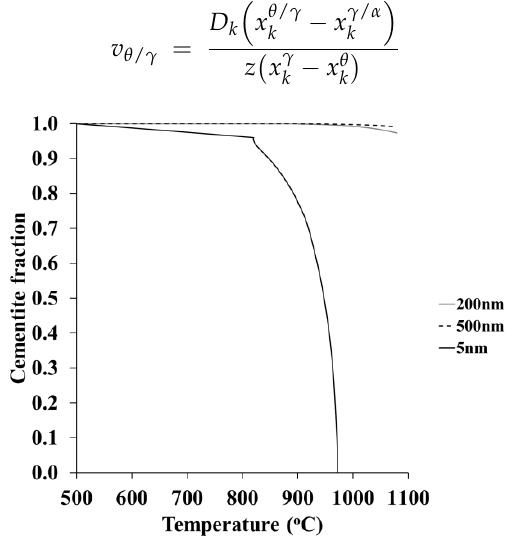
Figure 8. Examining cementite dissolution according to the initial size of carbides into the microstructure. It was identified that as carbides’ size increases, dissolution rate tends to be diminished during a 5 s heating stage. Significant shrinking was detected only for carbides with 5 nm size.